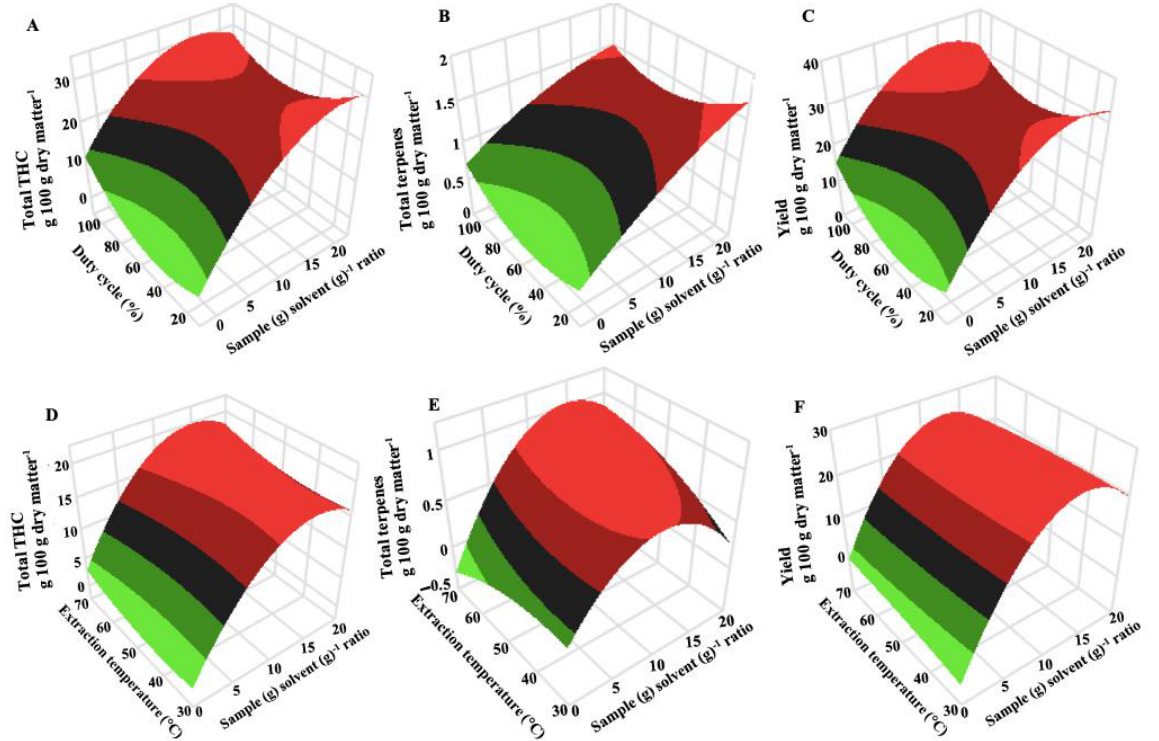
Figure 2. 3D response surface plots illustrating the combined effects of sample (g) solvent (g) − 1 and duty cycle (%) for ultrasound-assisted extraction ( A – C ) and sample (g) solvent (g) − 1 and extraction temperature ( ◦ C) for microwave-assisted extraction ( D – F ) on the concentration (g 100 g dry matter − 1 ) of total THC ( A , D ), total terpenes ( B , E ), and extraction yield ( C , F ).